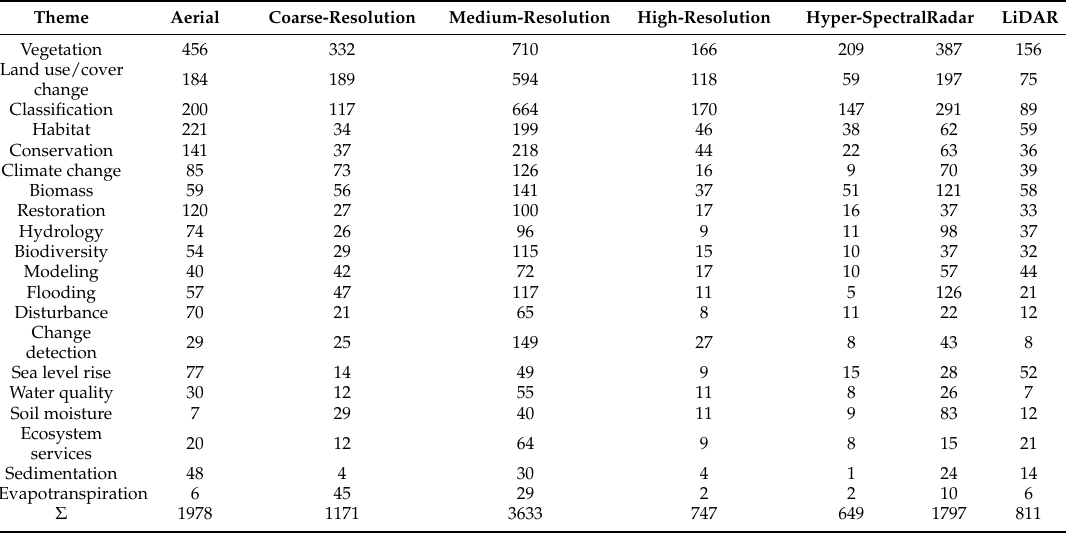
Table 1. Remote sensing sensor usage frequency for different